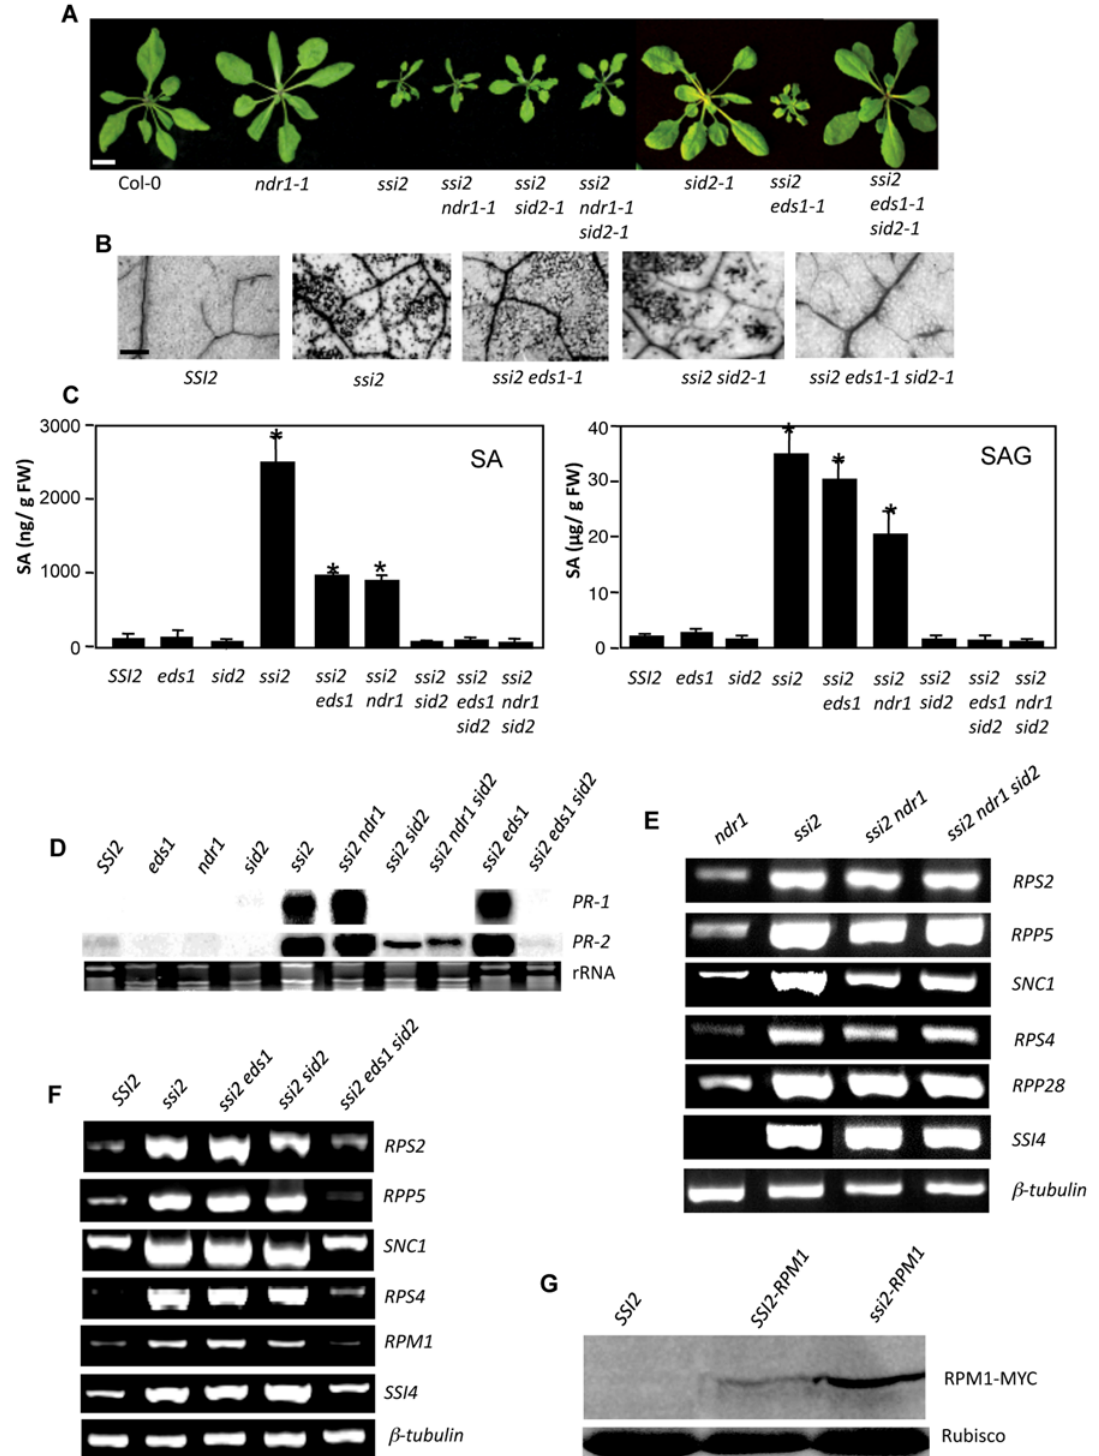
Figure 1. Morphological, molecular, and defense phenotypes of ssi2ndr1-1sid2-1 and ssi2eds1-1sid2-1 plants. (A) Comparison of the morphological phenotypes displayed by 3-week-old soil-grown plants (scale, 0.5 cm). (B) Microscopy of trypan blue-stained leaves from wt ( SSI2 , Col- 0 ecotype), ssi2 , ssi2 eds1-1 , ssi2 sid2-1 and ssi2 eds1-1 sid2-1 plants (scale bars, 270 microns). (C) SA and SAG levels in indicated genotypes. The error bars indicate SD. Asterisks indicate data statistically significant from wt No¨ ecotype ( SSI2 ) (P , 0.05, n=4). (D) Expression of PR-1 and PR-2 genes in indicated genotypes. Total RNA was extracted from 4-week-old plants and used for RNA gel-blot analysis. Ethidium bromide staining of rRNA was used as the loading control. The PR-1 transcript levels in EDS1 SID2 F2 plants were similar to those of wt plants (data not shown). (E) RT-PCR analysis of various R genes in indicated genotypes. The level of b -tubulin was used as an internal control to normalize the amount of cDNA template. (F) RT-PCR analysis of various R genes in indicated genotypes. The level of b -tubulin was used as an internal control to normalize the amount of cDNA template. The expression of R genes in EDS1 SID2 F2 plants was similar to that of wt plants (data not shown). (G) Levels of Myc-tagged RPM1 protein in indicated genotypes. Levels of Rubisco were used as the loading control. doi:10.1371/journal.pgen.1000545.g001 PLoS Genetics |